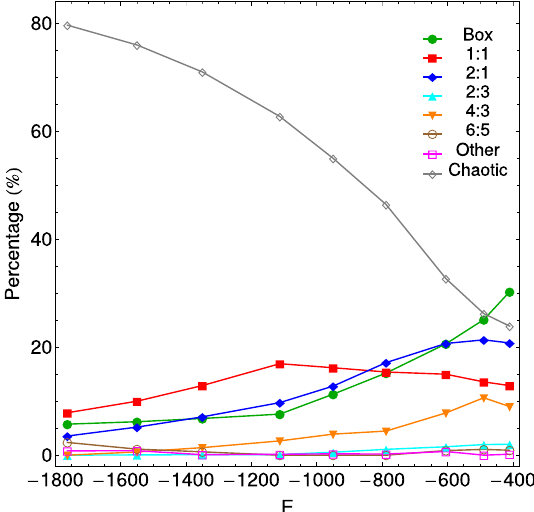
Fig. 3. Evolution of the percentages of different types of orbits in the phase plane ( R; ˙ R ) of our galaxy model as a function of the total orbital energy E